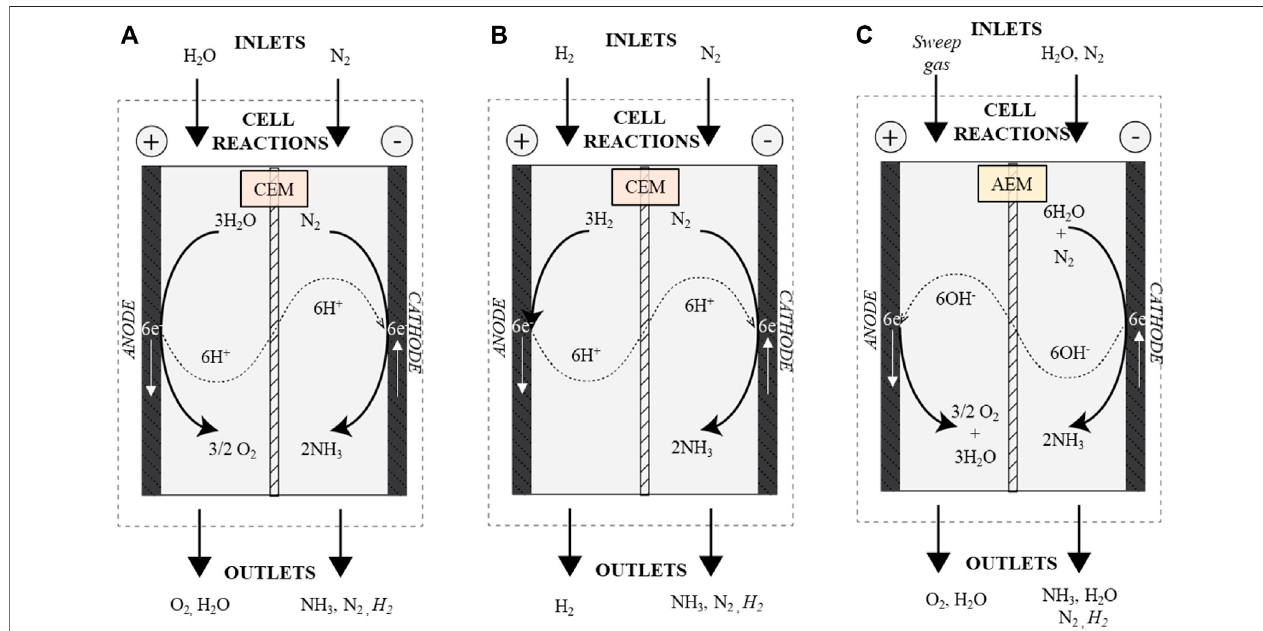
FIGURE 1 | Cell arrangements for electrochemical ammonia synthesis including anodic and cathodic reaction paths (A) water fed cell (H 2 O-fed) using a cation exchange membrane (CEM) (B) hydrogen fed (H 2 -fed) cell using a CEM and (C) water fed cell (H 2 O-fed) using an anion exchange membrane (AEM).